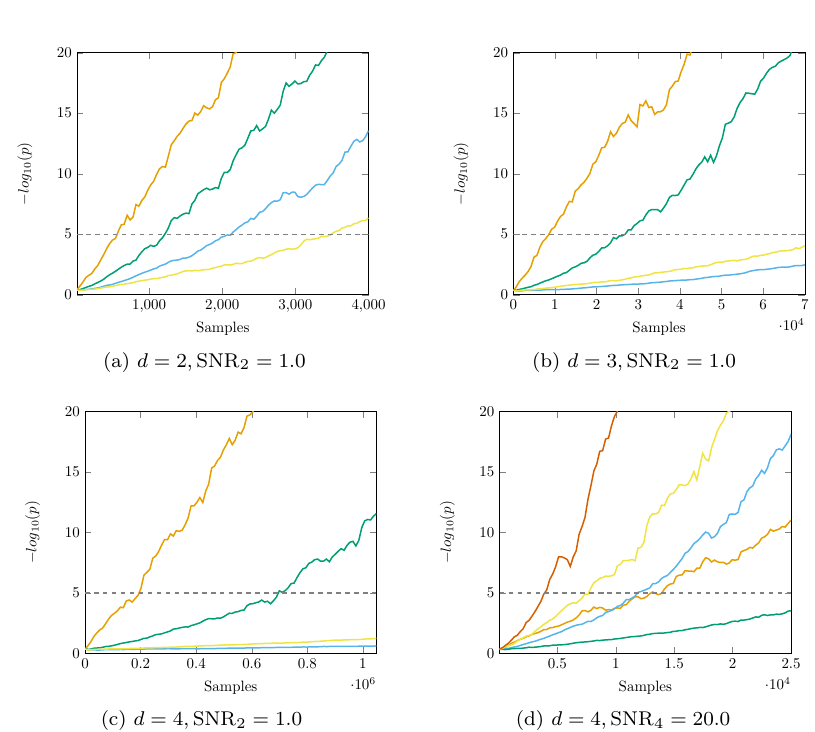
Figure 5: Performance of the (orange) t -test with normalized product, (green) χ 2 -test with normalized product, (yellow) χ 2 -test with sum combining, and (blue) χ 2 -test with multivariate histograms for simulated multivariate 2nd-, 3rd-, and 4th-order leakages with SNR 2 = 1 . 0.